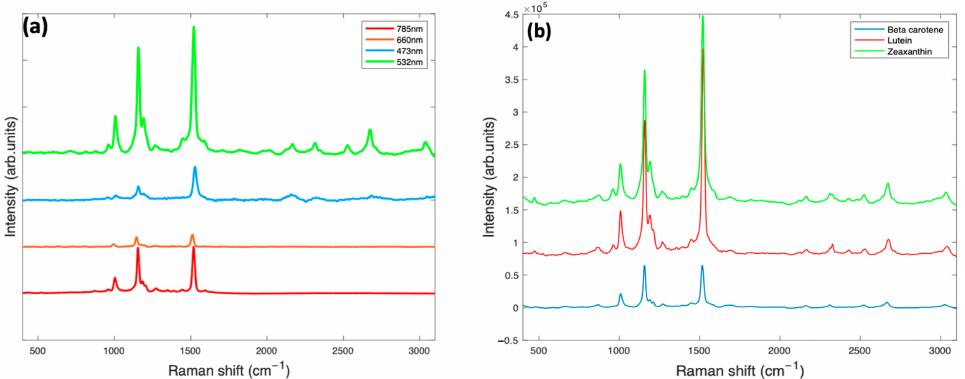
Figure 4. ( a ) Beta carotene spectrum at multiple wavelengths and ( b ) 532 nm spectrum of beta carotene, lutein and